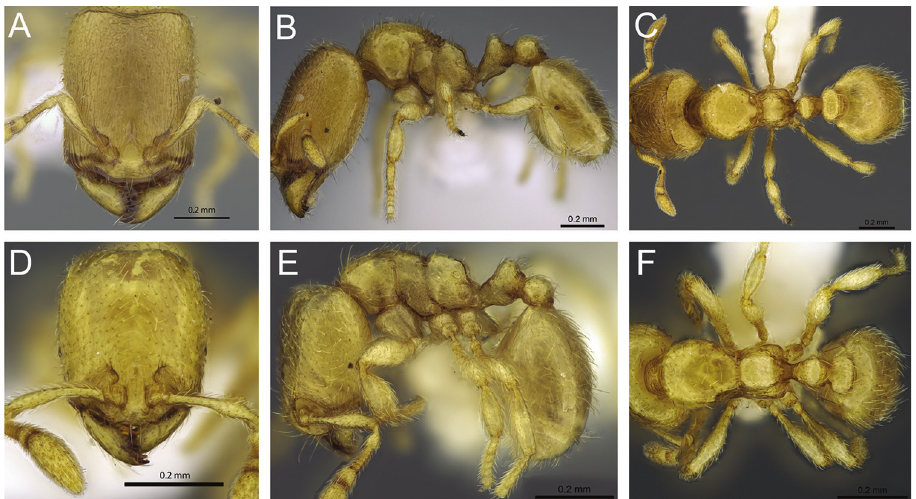
Figure 36. Carebara demeter –holotype. Major worker, CASENT0906157. A head in full-face view B body in profile view C body in dorsal view. Minor worker, CASENT0192568 D head in full-face view E body in profile view F body in dorsal